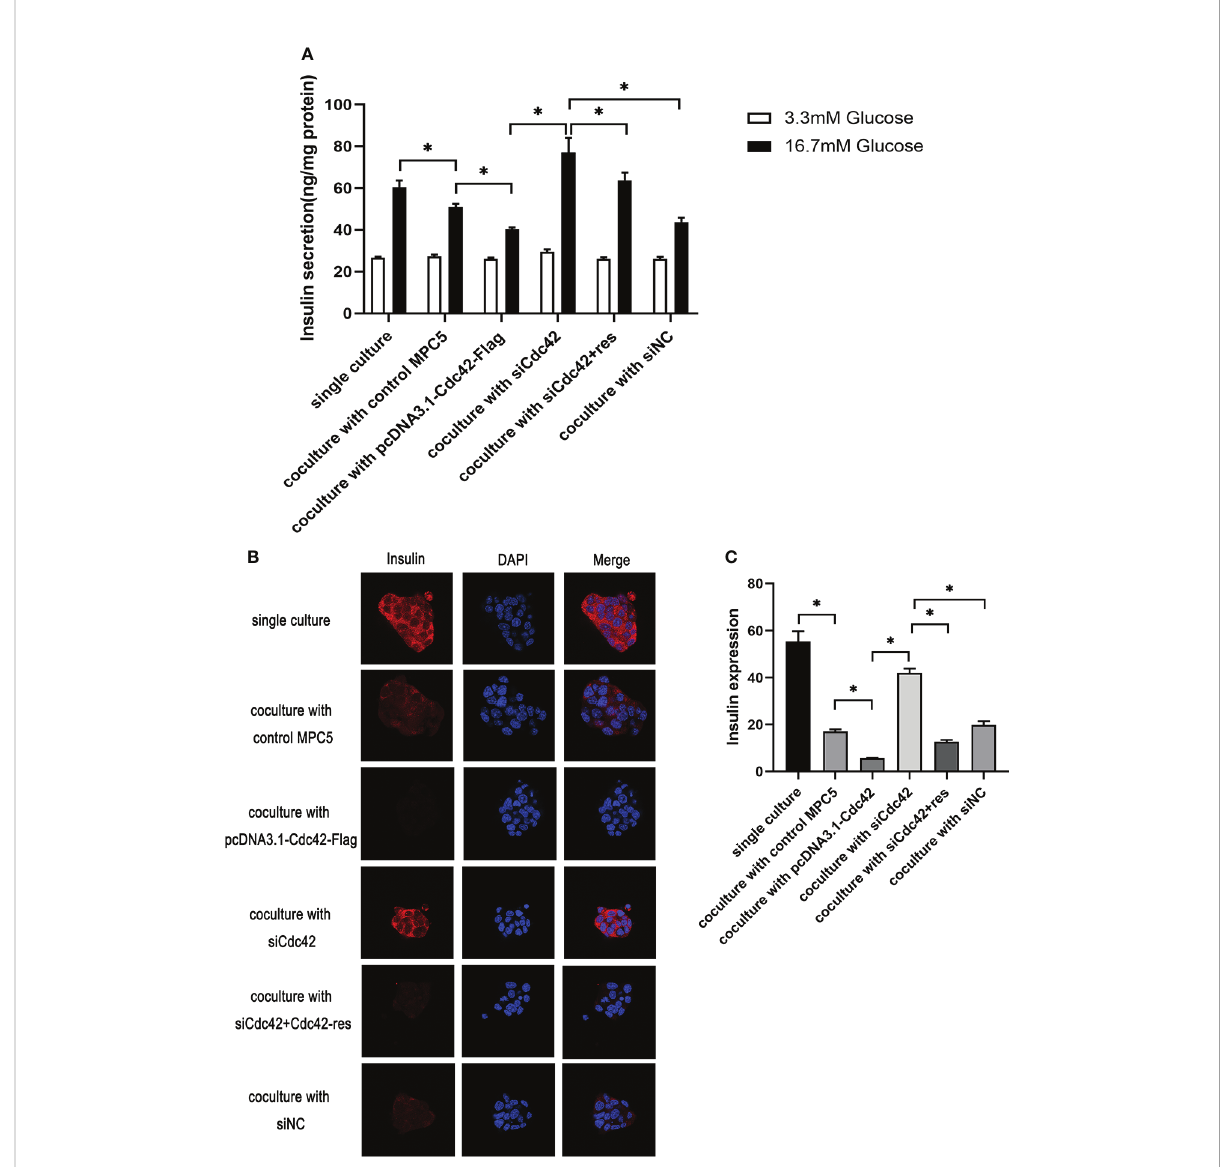
FIGURE 5 Upregulation of Cdc42 in podocytes impaired glucose-stimulated insulin secretion (GSIS) and insulin expression in b -TC6 cells. (A) A co-culture with MPC5 cells resulted in impaired insulin secretion from b -TC6 cells stimulated with 16.7 mM glucose compared with the monocultured group. The upregulation of Cdc42 in MPC5 cells diminished the GSIS of b -TC6 cells compared to the siNC group without a change in basal insulin secretion, while the impaired GSIS of b -TC6 cells was reversed by co-culture with MPC5 cells transfected with siCdc42. However, insulin secretion was partially restored when cotransfected with siCdc42 and Cdc42-res in MPC5 cells. (B) Immuno fl uorescence staining for insulin (red dots) showed a lower expression in the b -TC6 cells when co-cultured with MPC5 cells compared with monocultured b -TC6 cells. The upregulation of Cdc42in MPC5 cells signi fi cantly reduced the insulin expression in b -TC6 cells compared to the siNC group. When Cdc42 was suppressed in MPC5 cells, the insulin level was signi fi cantly upregulated in b -TC6 cells. Nevertheless, this effect was counteracted when co- cultured with MPC5 cells transfected with siCdc42 and Cdc42-res; original magni fi cation: ×400. (C) The quantitative expression of insulin was examined, and no signi fi cant difference was observed. The data are presented as mean ± SEM; * P <